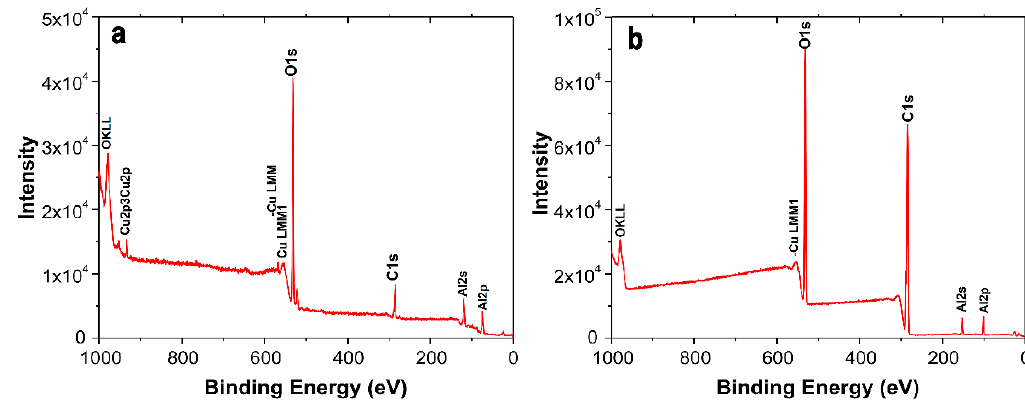
Figure 1. X-ray photoelectron spectroscopy (XPS) spectra of the differently pretreated AA2024 aluminum alloy: ( a ) chemically etched (AA); ( b ) chemically etched and pseudotransesterification treated (AA-TE).